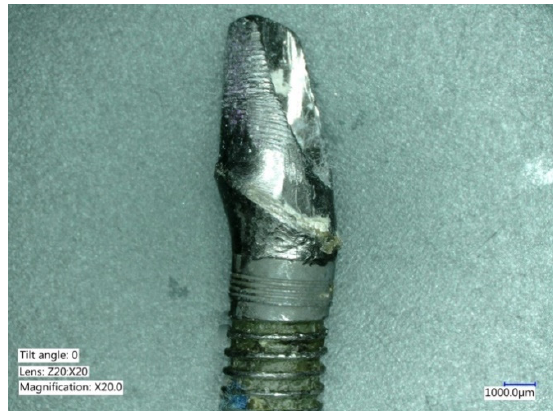
Figure 11. The evaluation of the removed crown abutment, also showed titanium particles and tita- nium delamination. Surface changes were also evident at the transmucosal portion of the abutment.